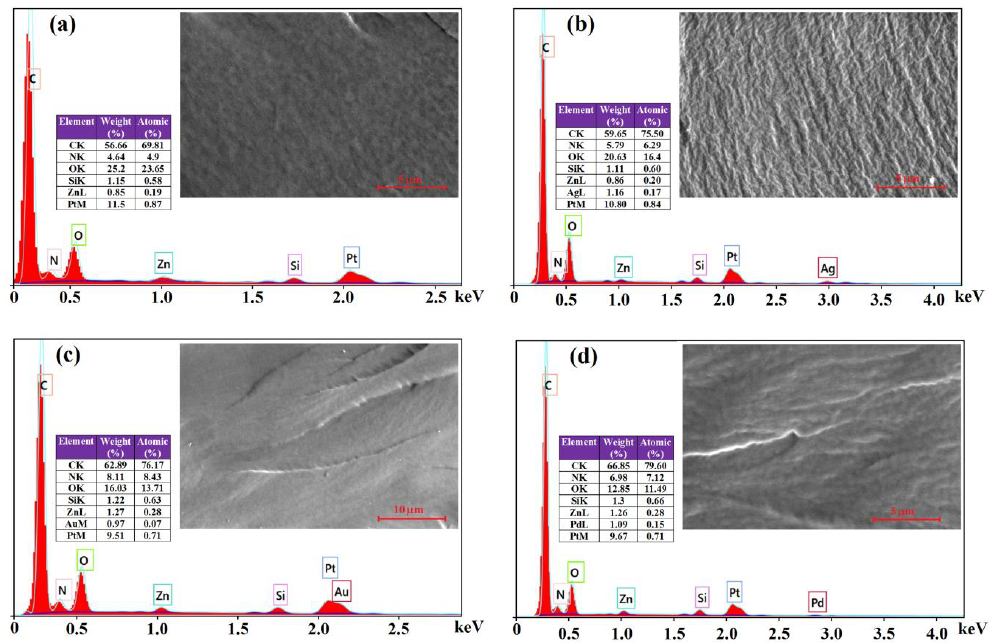
Figure 8. Energy-dispersive X-ray spectroscopy (EDX)spectra and scanning electron microscopy (SEM)micrographs of fractured cross-sections of composite films M1 ( a ), M1-Ag ( b ), M1-Au ( c ) and M1-Pd ( d ).